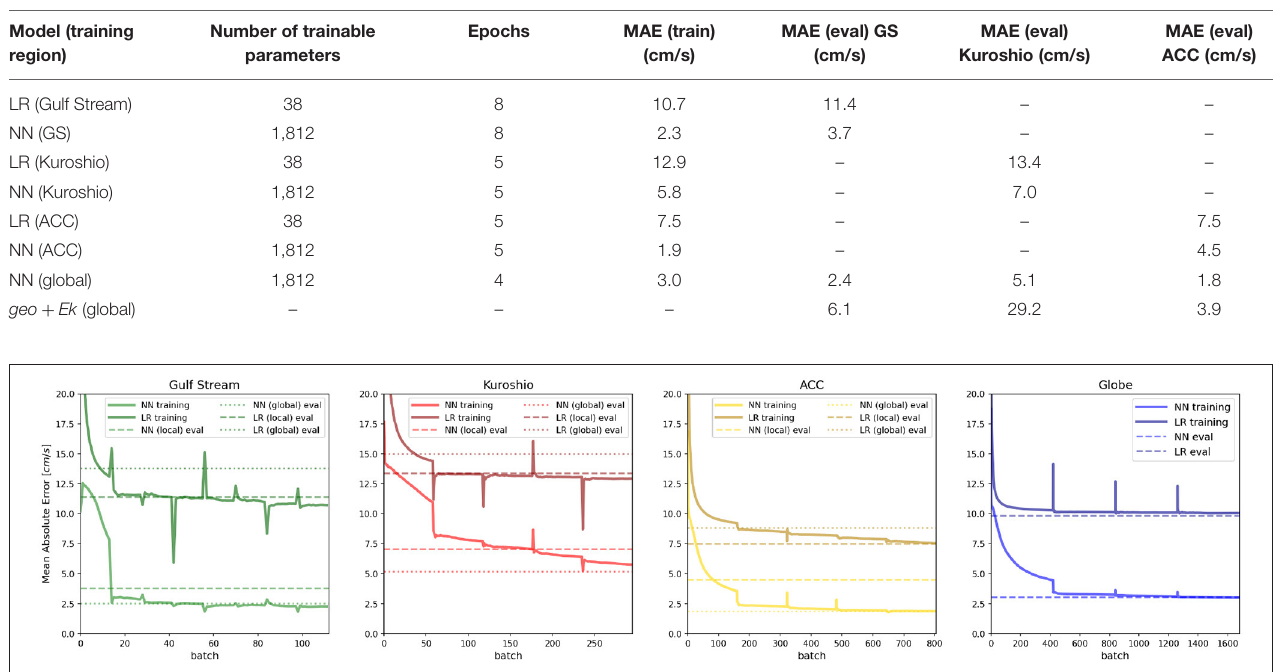
FIGURE 3 | Evolution of the loss function (mean absolute error; MAE) for Neural Networks and Linear regression models during training. Horizontal lines of the corresponding color denote the MAE for the model when evaluated at a different time snapshot. Dashed lines denote the evaluated (test data) MAE for the local model and dotted lines denote that for the model trained on the globe.